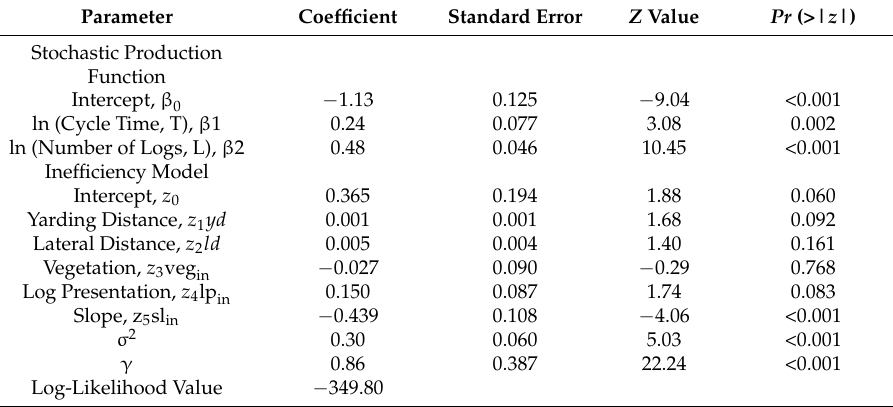
Table 6. Maximum Likelihood Estimates of the Parameters of the Stochastic Frontier Analysis.